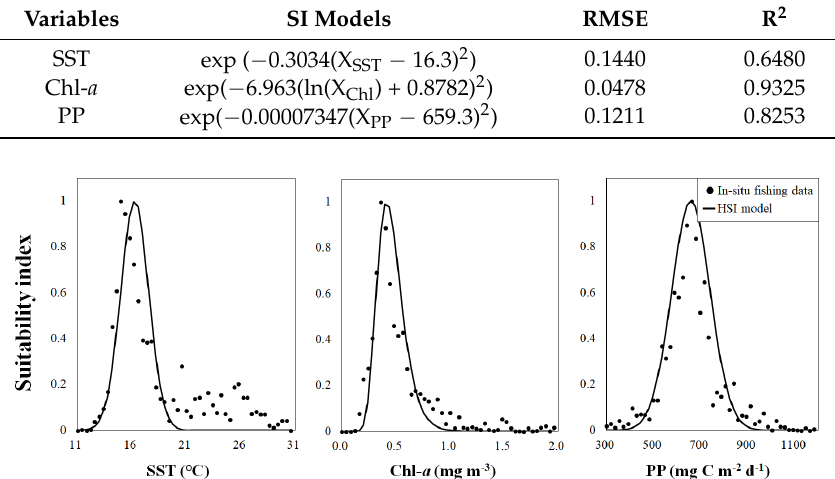
Table 2. Suitability index (SI) models derived from three environmental parameters (SST, Chl- a , and PP).